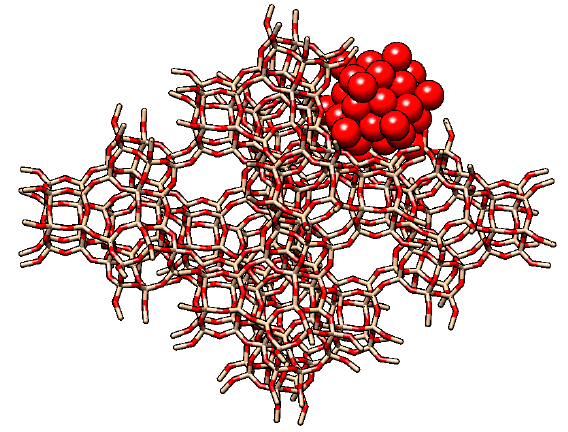
Figure 4. Location of Keggin polyoxometalate on the surface of Y zeolite (colors same as in Figures 1 and 2).